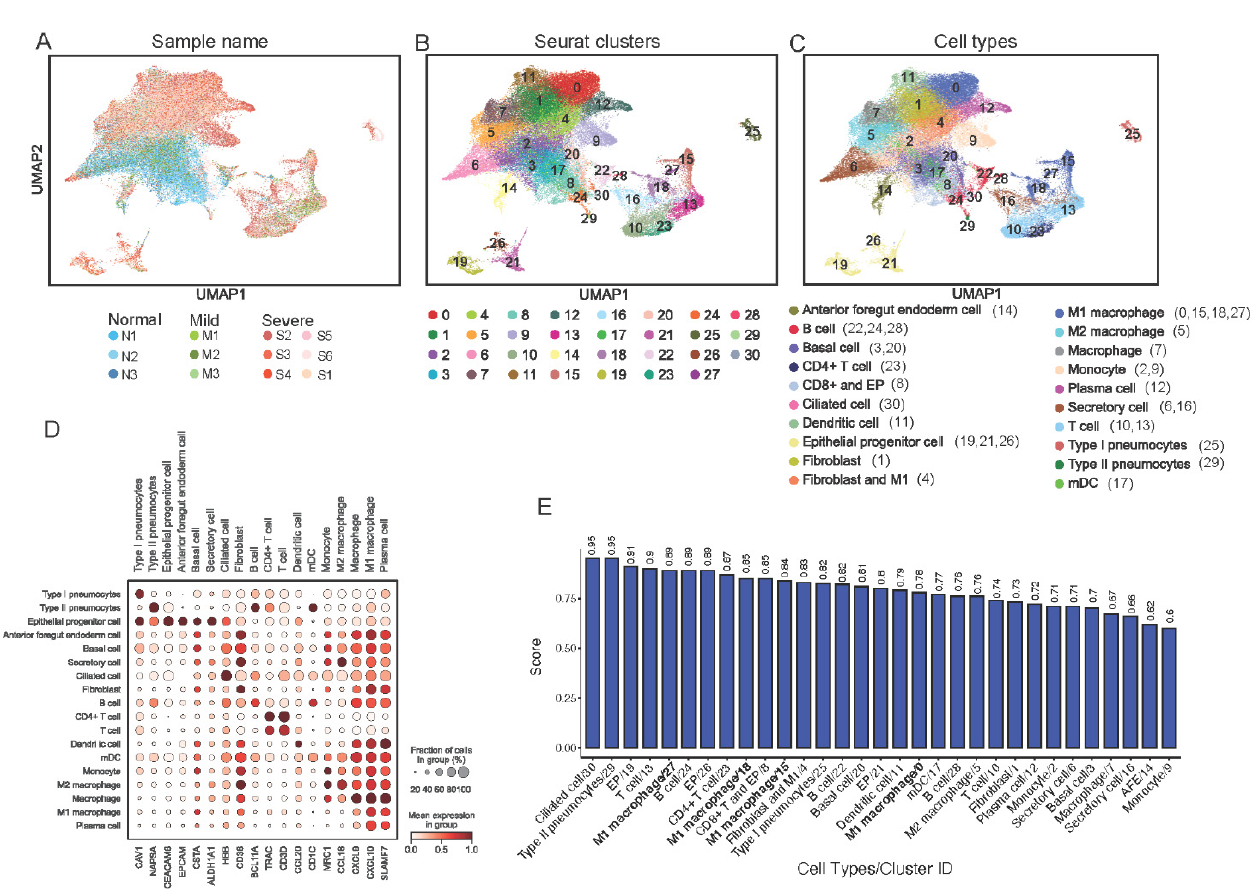
Table 2. The percentage of cells in each cluster for each patient. N, M, and S represent severity groups, respectively, while the number after the group represents the patient ID in the correspond- ing group; for example, N1 represents patient 1 in the normal group. Note: the summation of per- centage in each column is 1, representing the cell composition of a sample (see also Figure S2).